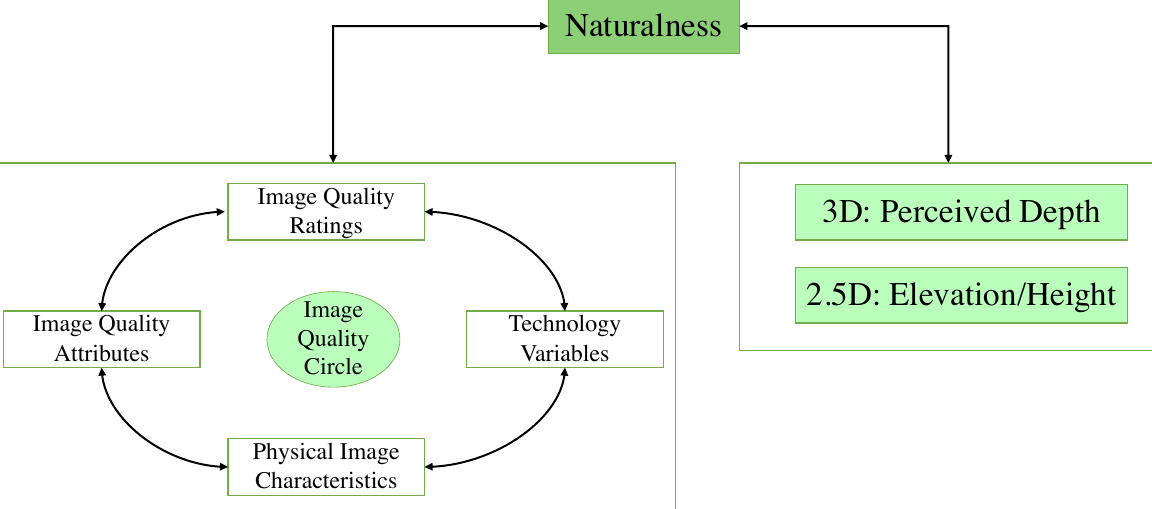
Figure 1. Slight modification proposal of Heynderickx [11] model with regard to 2.5D prints. We propose to consider elevation (or height) as the representative attribute that affects the naturalness perception of 2.5D prints in this